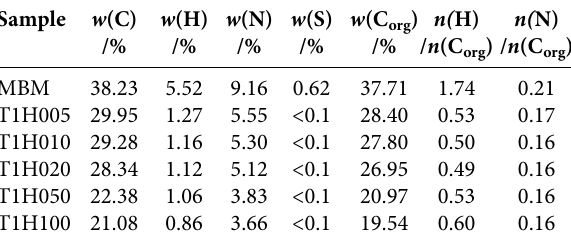
Table 2. Results of CHNS analyses of MBM and T1ABC samples and calculated quantities and ratios.